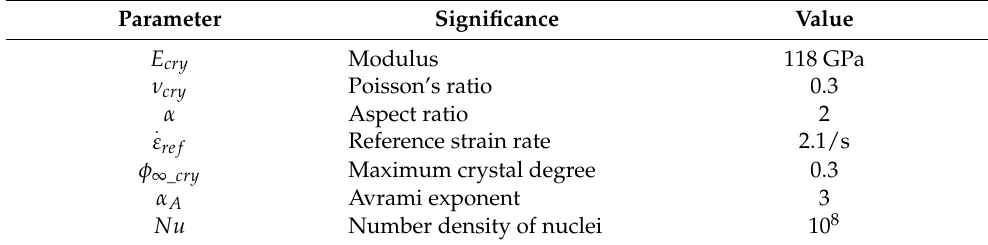
Table 1. Model constants for the crystalline phase.